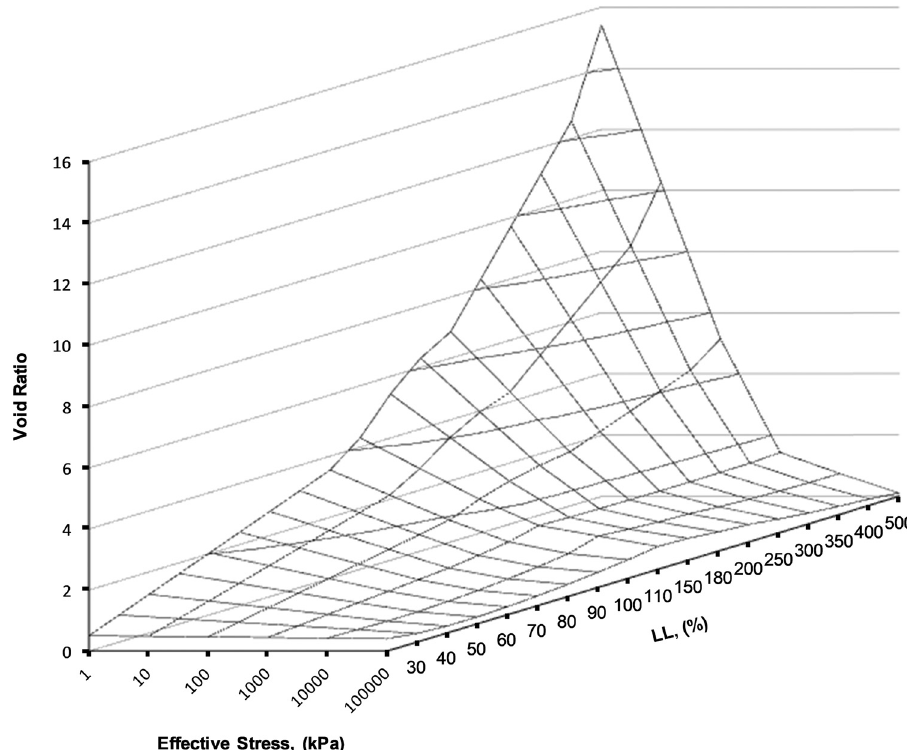
Figure 14: 3D predicted 1D - NCL ’ s for large stresses vs LL.